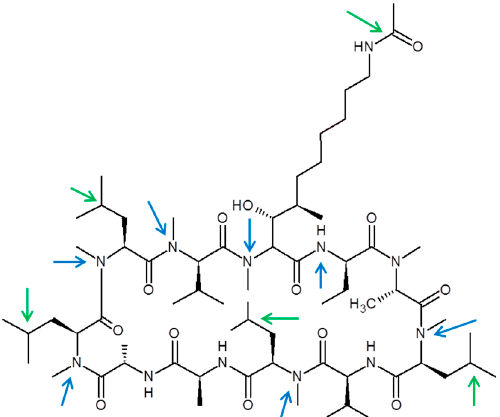
Figure 5. Chemical structure of CRV431 and proposed biotransformation sites. Potential oxidation (green arrows) and demethylation (blue arrows) sites are shown.